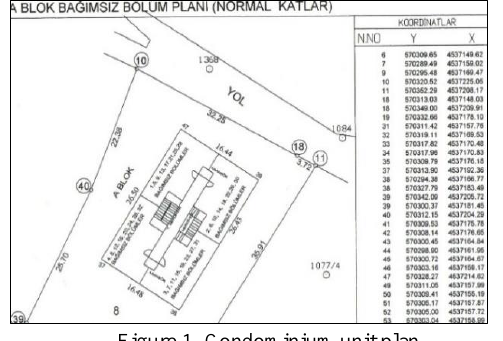
Figure 1. Condominium unit plan